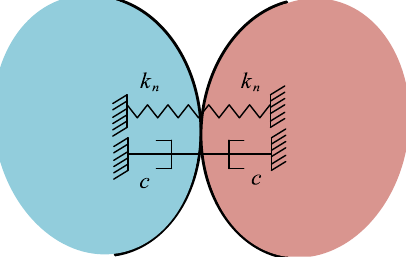
Figure 8. Normal contact force model in MSC